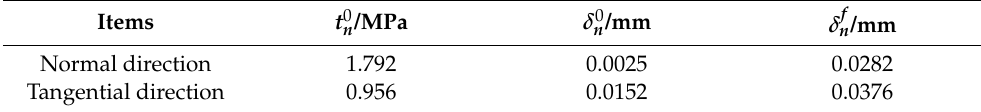
Table 2. Cohesion model parameters.